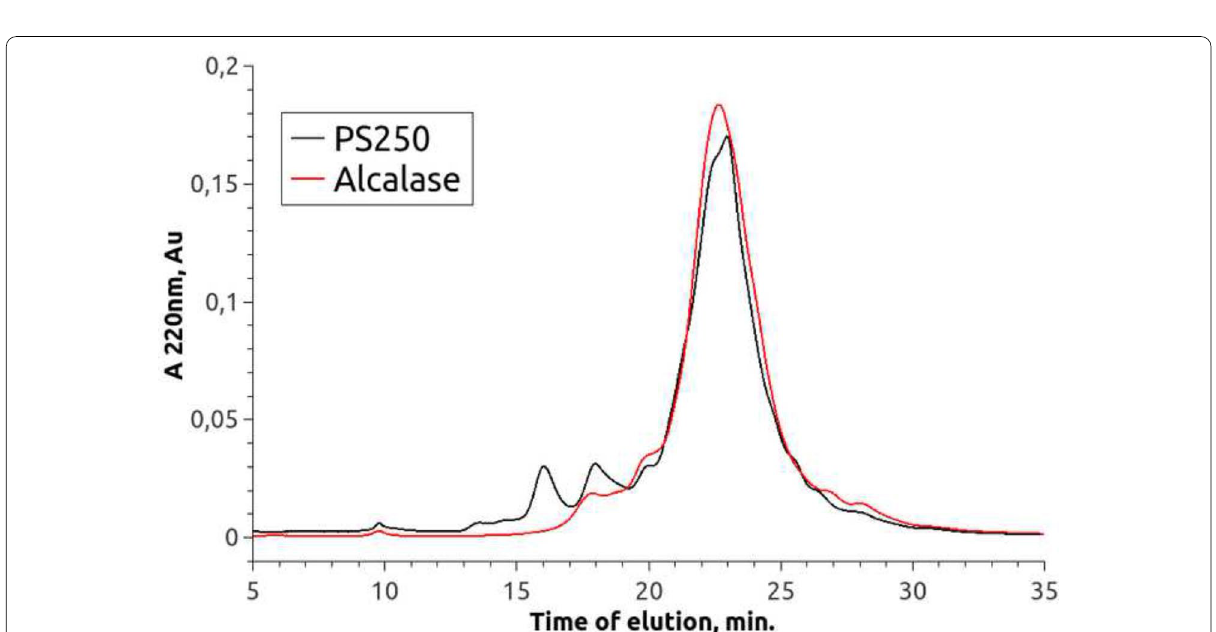
Fig. 8 Chromatograms of SPI hydrolysate after treatment with Alcalase and Protosubtilin The SPI hydrolysate was obtained by enzymatic hydrolysis of 20% SPI isolate Shansong 90 using commercial enzymes Alcalase and Protosubtilin G3x with protease activity 11.9 Units/g of SPI at 50 ◦ C with no